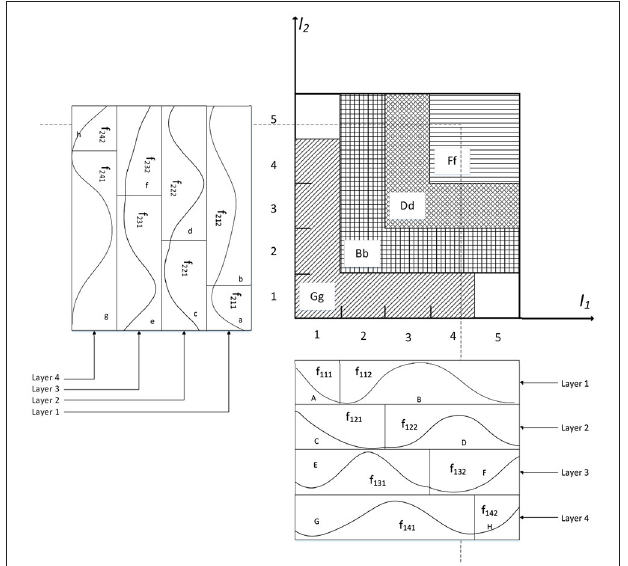
FIGURE 2 | Organization of an example 2-D FNN.